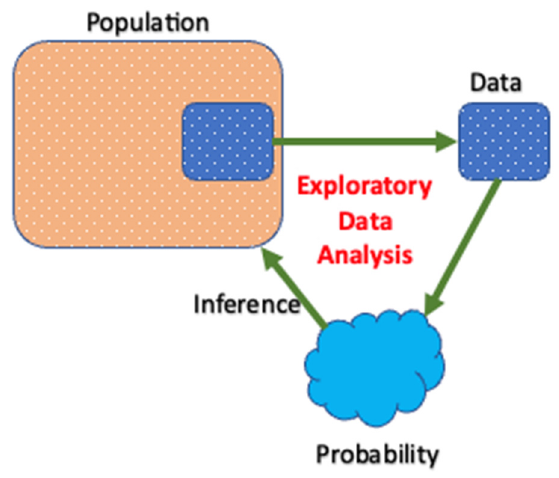
Figure 2. Exploratory data